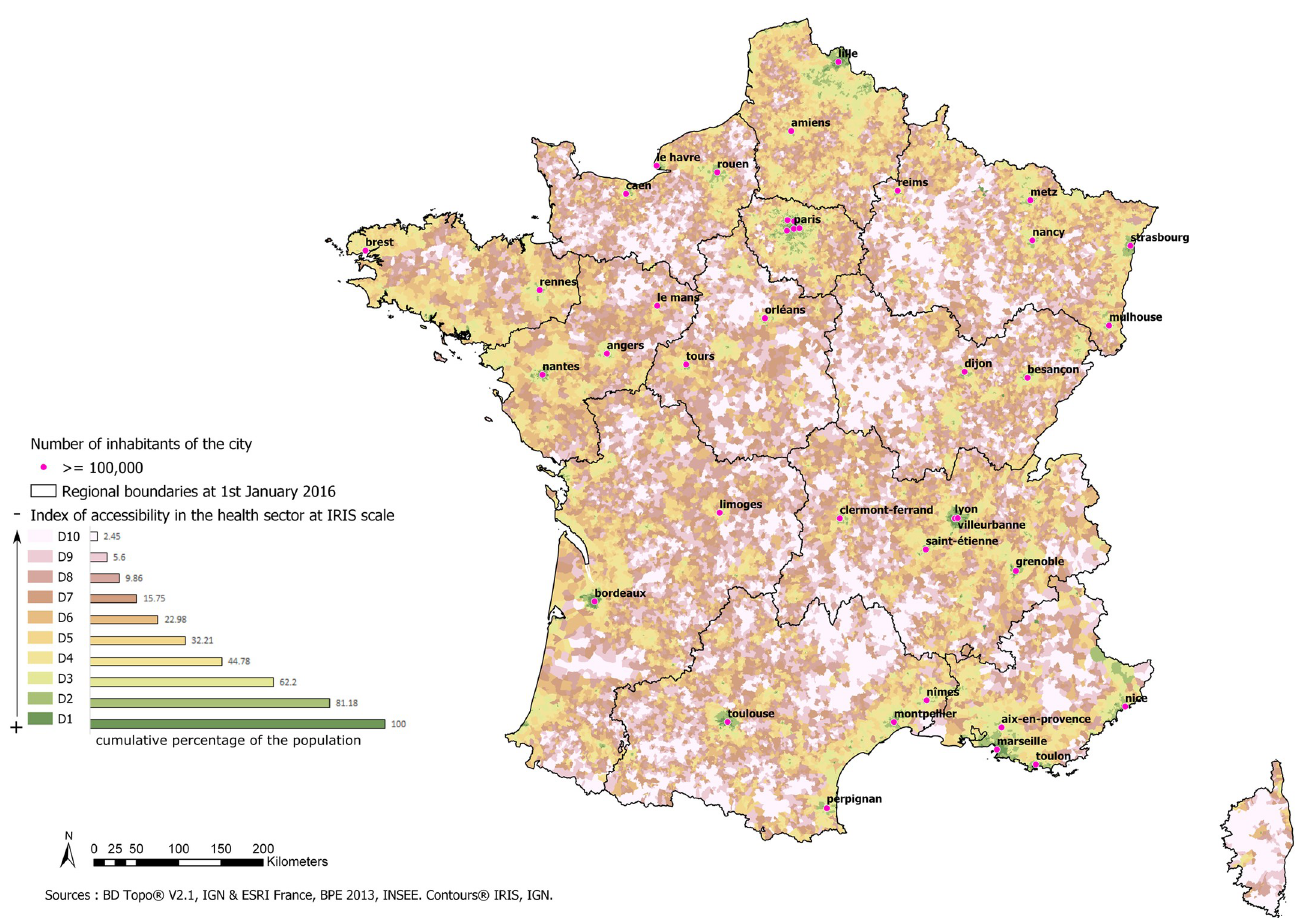
Fig 5. Health accessibility index at IRIS level in metropolitan